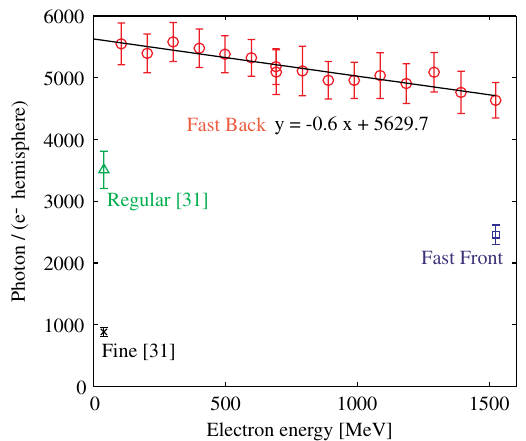
FIG. 6. The number of photons emitted from the Lanex per electron as a function of the electron energy: circles, Lanex Fast Back; square, Lanex Fast Front; triangle, Lanex Regular [32]; cross, Lanex Fine [32]. The solid line is a linear fit for the Lanex Fast Back. The errorbars are the convolution of the fit error and the error of the total